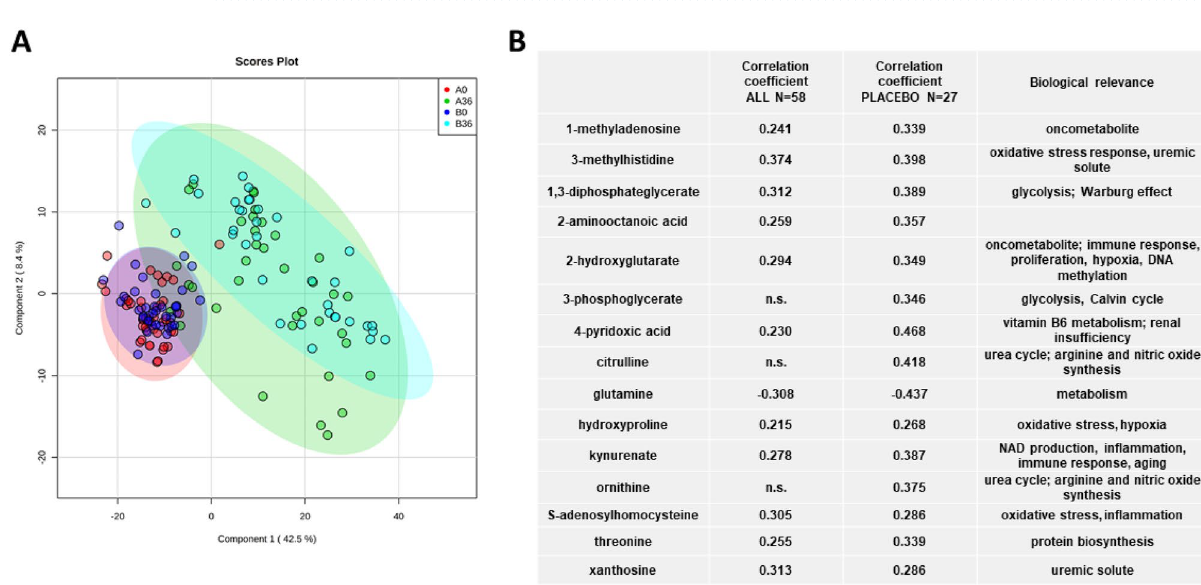
Figure 3. ( A ) Principal component analysis between pediatric ADPKD patients at the baseline (0 months) and after 36 months of treatment (group A = pravastatin, N = 31, group B = placebo, N = 27) and ( B ) Pearson correlation coefficients between the percent change HtTKV to a percent change in metabolites (significant after adjustment to age, gender, race (placebo, N = 27) as well as treatment group (both groups combined = ALL, N = 58). Percent change was calculated by normalizing the change over time (Δ(36–0) months) to the corresponding baseline. Ellipses represent 95% confidence intervals for each individual group on the PCA